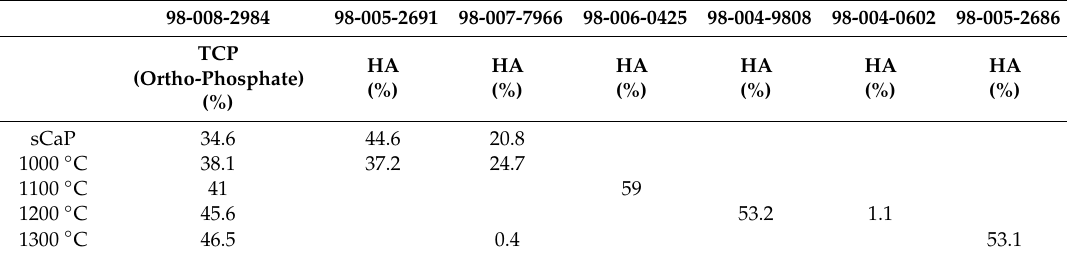
Figure 2. XRD patterns of sintered salmon-derived calcium phosphates (sCaP) powders ( a ) 800 ◦ C, ( b ) 1000 ◦ C, ( c ) 1100 ◦ C, ( d ) 1200 ◦ C and ( e ) 1300 ◦ C. Table 1. Quantitative analysis of the crystalline phases formed according to JCPDS